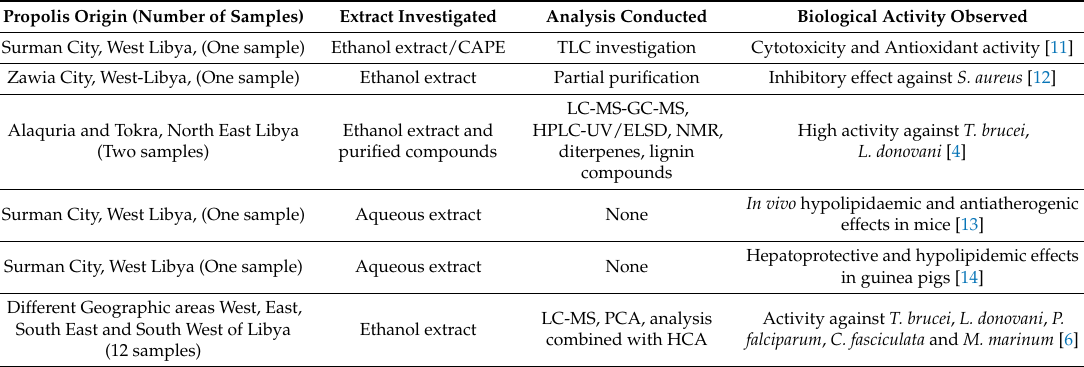
Table 1. Summary of previous studies on Libyan propolis.